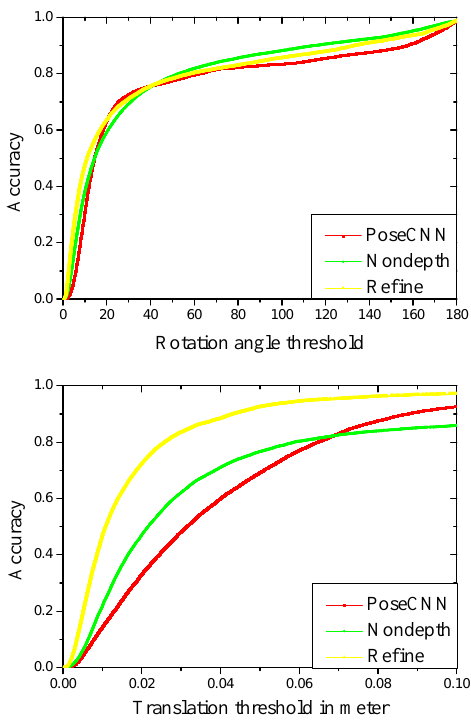
Figure 6. Accuracy of Rotations and